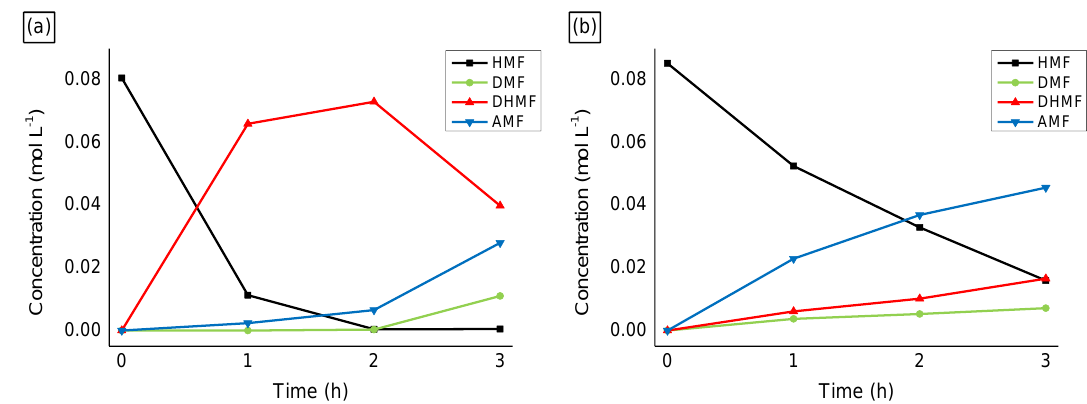
Figure 6. HMF hydrogenation reaction profile on ( a ) Ru/CNFs and on ( b ) Ru/CNFs-N. Reaction conditions: HMF, 0.08 M, substrate/metal = 100 mol/mol, solvent, 15 mL 2-butanol, 150 °C, 20 bar H 2 .